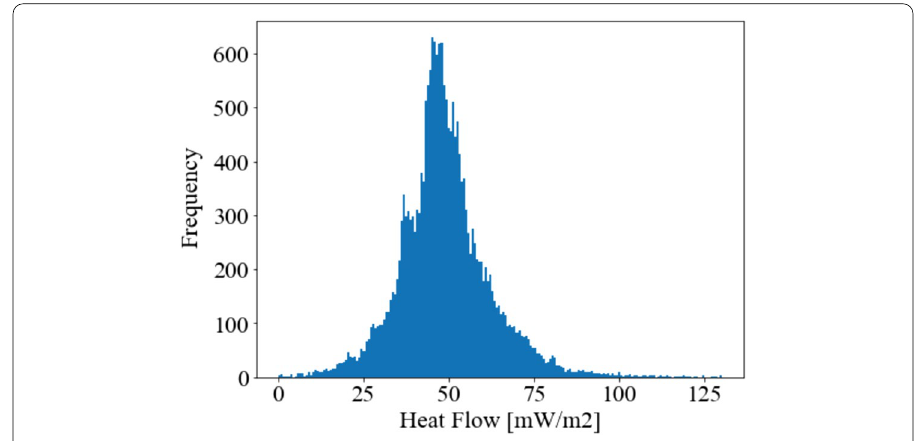
Fig. 2 Heat-flow histogram after outlier